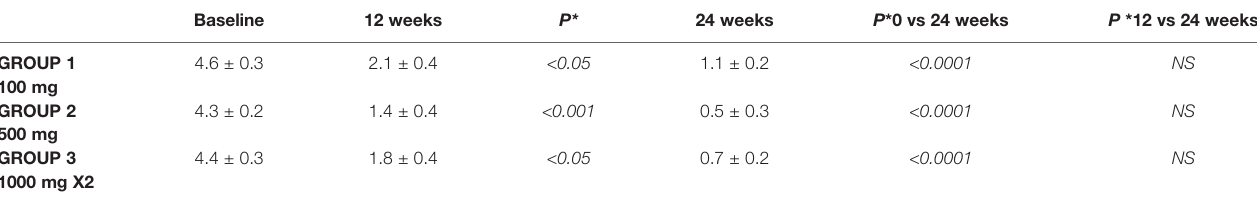
TABLE 2 | Clinical activity score (CAS) at baseline and 12 and 24 weeks after treatment with different doses of RTX.